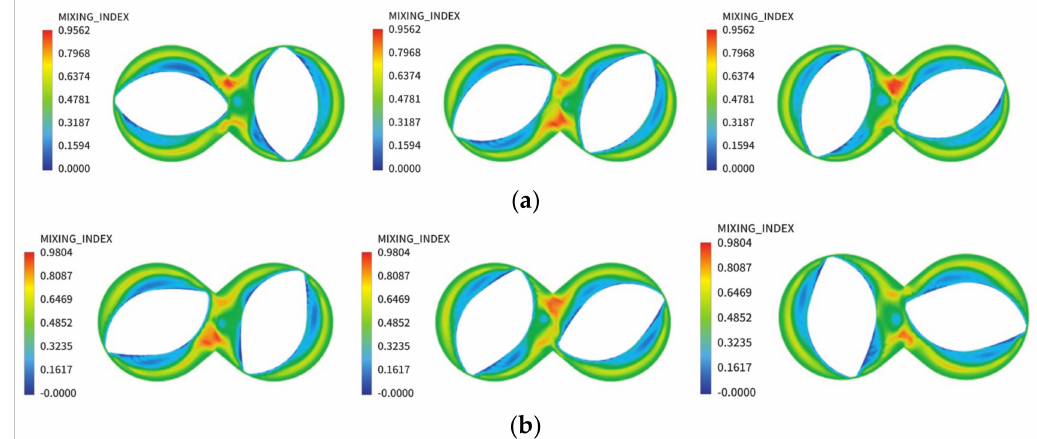
Figure 10. Mixed index field of the rotor ( a ) before and ( b ) after optimization.